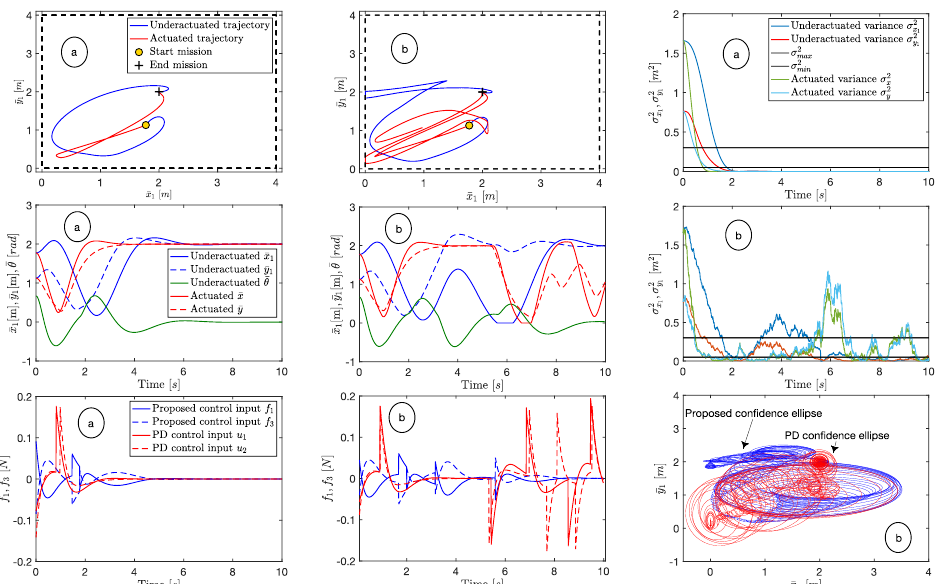
Figure 2. Simulation of control laws. ( a ): Automatic control of the mean and variance with 4 particles in the search space (black dashed line). Underactuated particle swarm under control Algorithms 1 and 2 over the fully-actuated [5]. ( b ): In the simulation, increased Brownian noise results in a more agile increase of